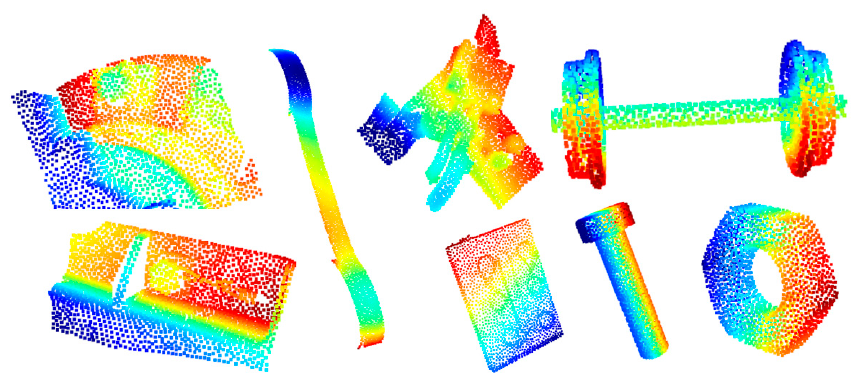
Figure 6. The train component point cloud.